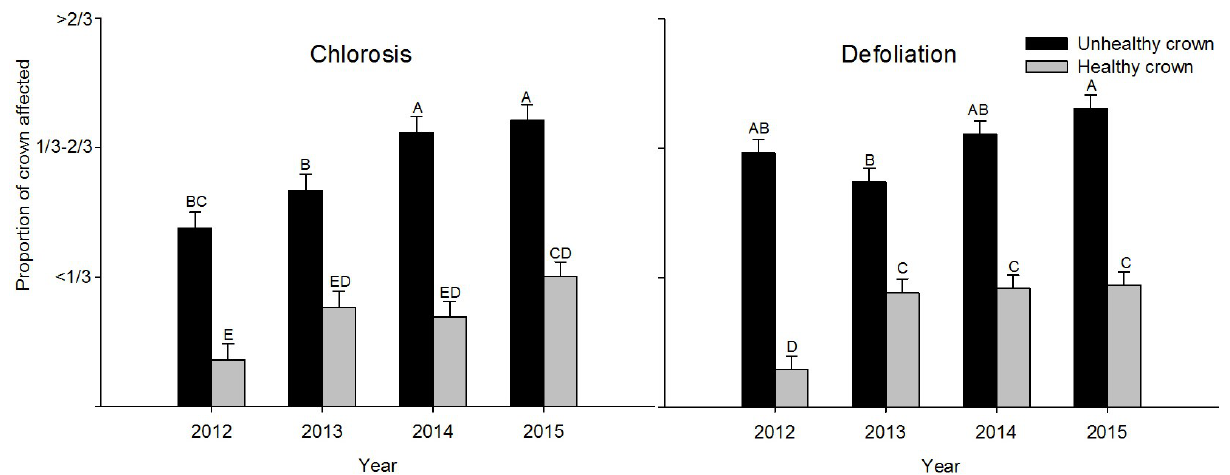
Figure 5. Frequency of chlorosis and defoliation of healthy and unhealthy eastern white pine at eight long-term monitoring sites from 2012 thru 2015. Bars represent means and standard errors ( N = 127 trees). Values with the same letter are not statistically different (α =